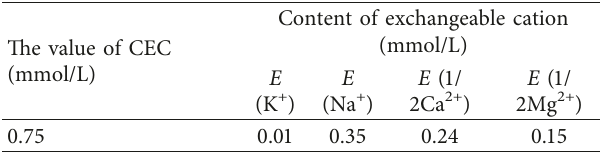
Table 3: Cation-exchange capacity and exchangeable ions com- position of GMZ001 bentonite.